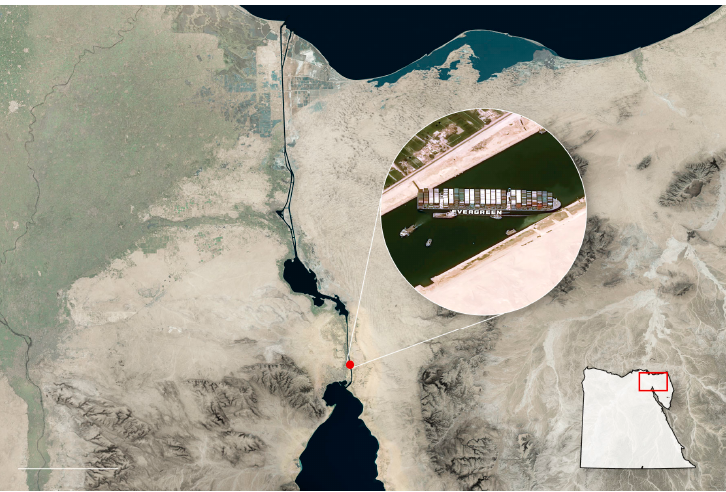
Figure 1. Ever Given Suez blockage. (photo credit: Airbus).